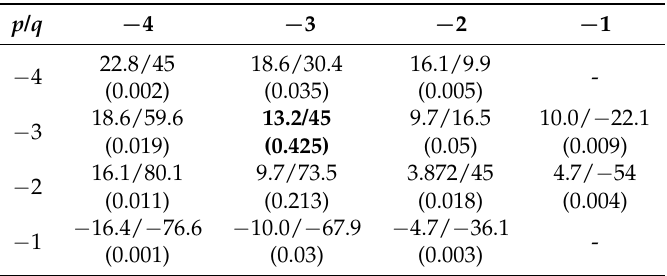
Table 1. Irradiance maxima of light at 1550 nm radiating on the DMD over a large solid angle θ out / φ out , ( I ) of each diffraction